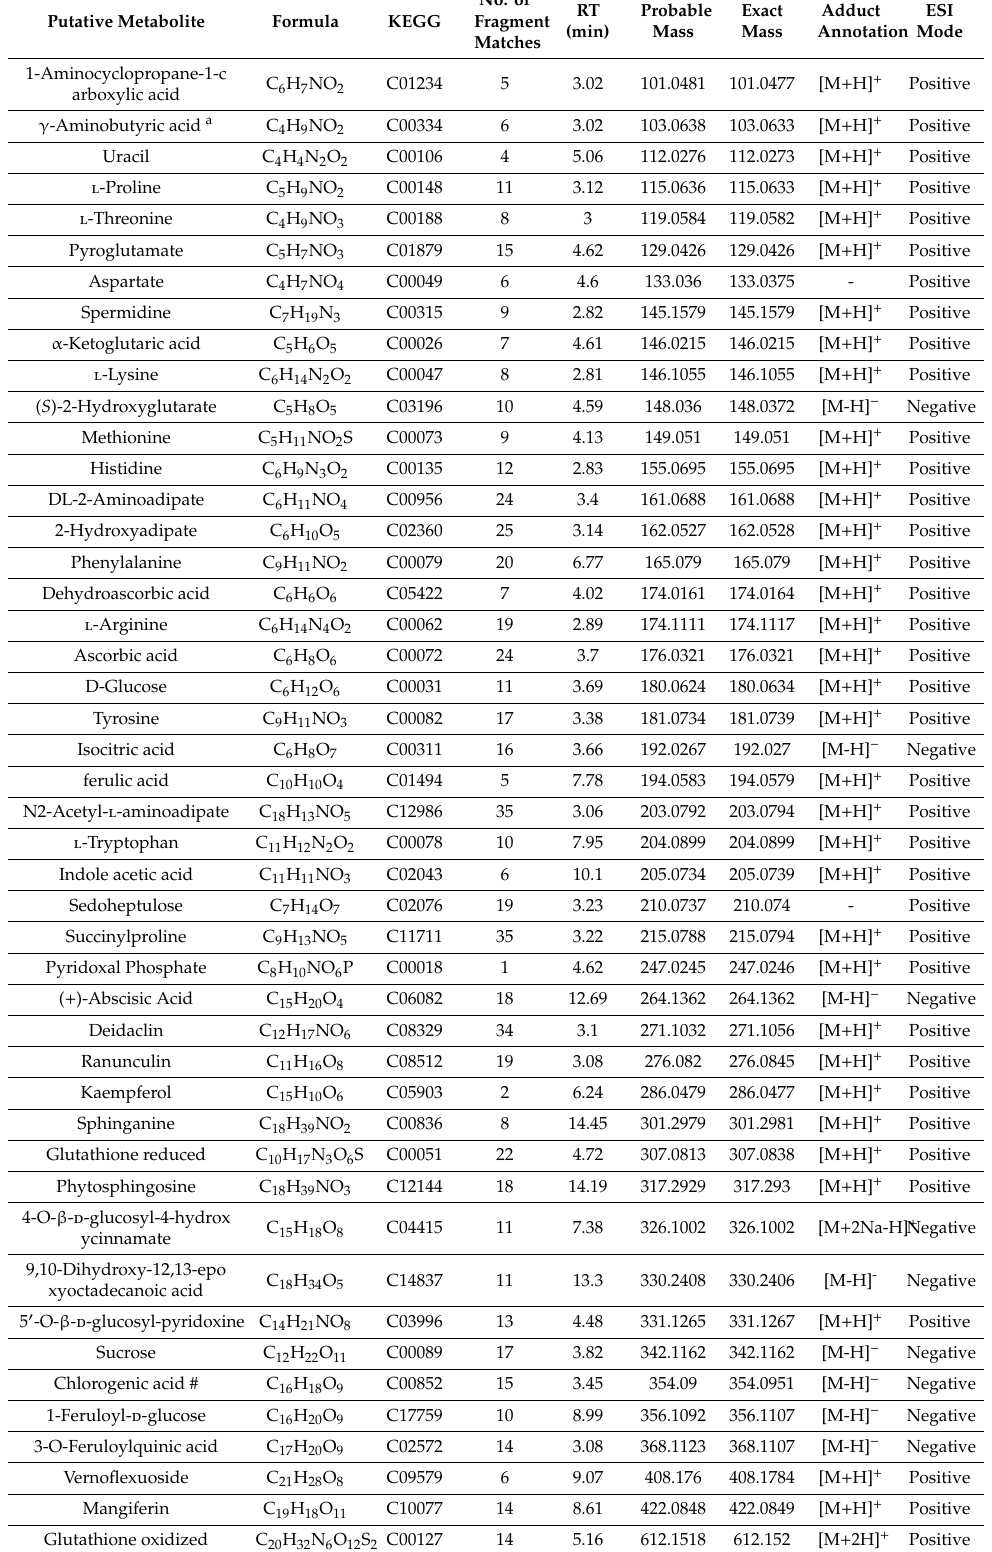
Table 1. List of putative metabolites identified and validated by tandem mass spectrometry. Metabolites annotated at the level 2 of Metabolites Standards Initiatives (MSI) [20]. Putative metabolites are arranged with the ascending order of exact masses (identified through KEGG